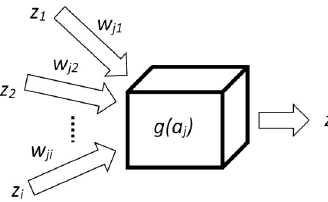
The structure of a neural network is formed by layers of neurons: input, hidden and output. In this research input neu- rons constitute a fluorescence spectrum and output neurons represent substances. Most computations are carried out in the hidden layers (no more than two layers were examined).